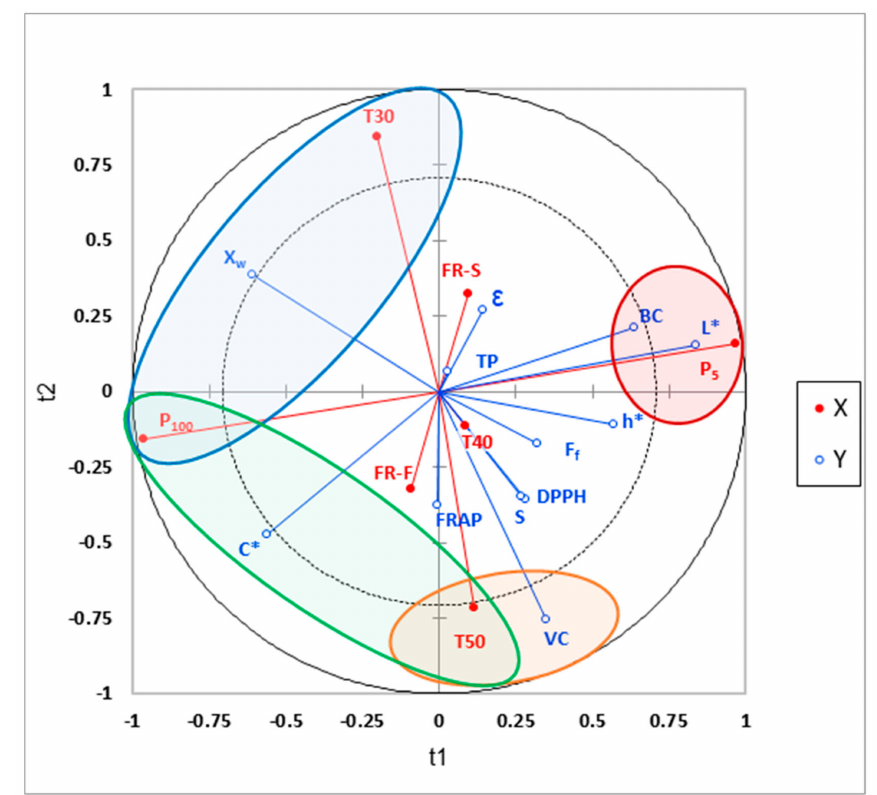
Figure 1. PLS-R projections of freeze-dried orange puree at a range or pressure, temperature and rate of freezing conditions. The dependent variables (X) are projected in red and the qualitative explanatory variables (Y) are projected in blue. The variables Y significantly correlated with a specific dependent variable are circled in red, blue, orange and green. Variables X: T30, T40, T50: shelf temperature applied during freeze-drying at 30, 40 and 50 ◦ C, respectively; P 5 and P 100 : working pressures of 5 Pa and 100 Pa respectively; FR-S: slow freezing rate and FR-F: fast freezing rate. Variables Y: percentage (Equation (7)) of TP: total phenols, VC: vitamin C, BC: beta carotene, antioxidant activity (FRAP and DPPH); F f : fracture force (N); S: slope related to rigidity (N / mm); Xw: water content (g water / 100 g sample); ε : porosity